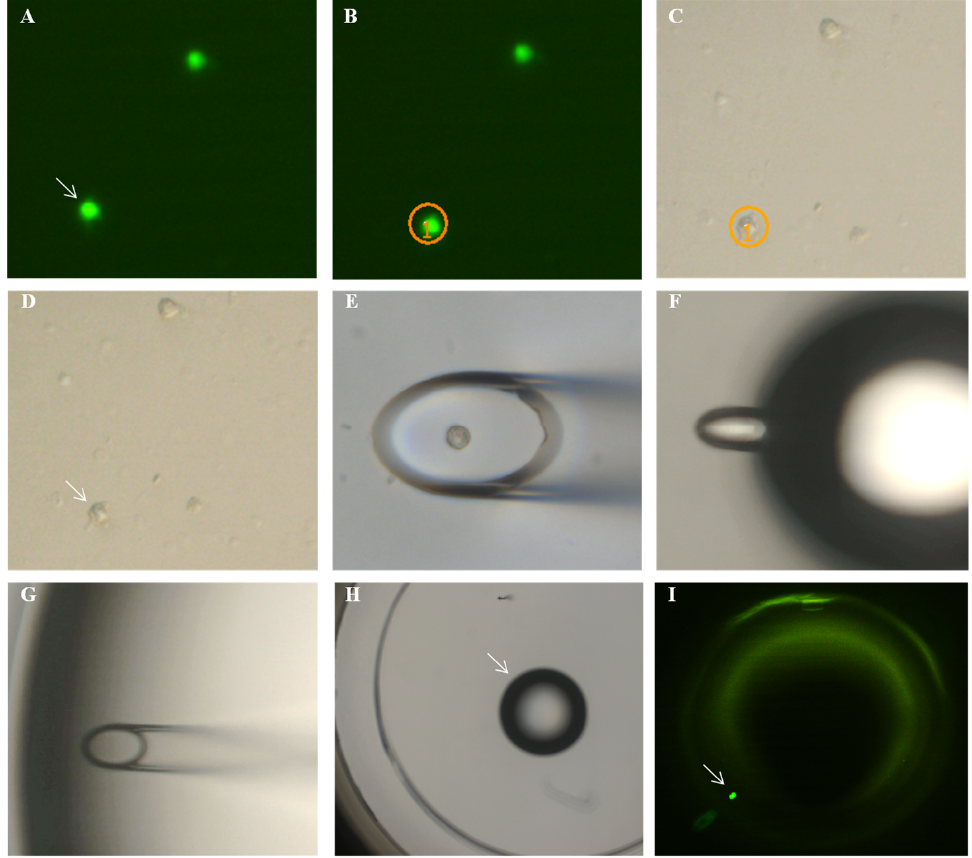
Figure 3. Steps of micromanipulation: ( A ) the cell to be picked is located in fluorescent light and ( B ) is circled by the software. ( C , D ) The cell is located in transmitted light. ( E ) The opening of the capillary is positioned over the cell and aspirates the cell. ( F ) The droplet with the cell is blown out from the capillary (diameter 25 µm), and ( G) it is confirmed that the cell is no longer inside the capillary but that it is released with the ( H ) droplet and can be detected ( I ) in fluorescent light.